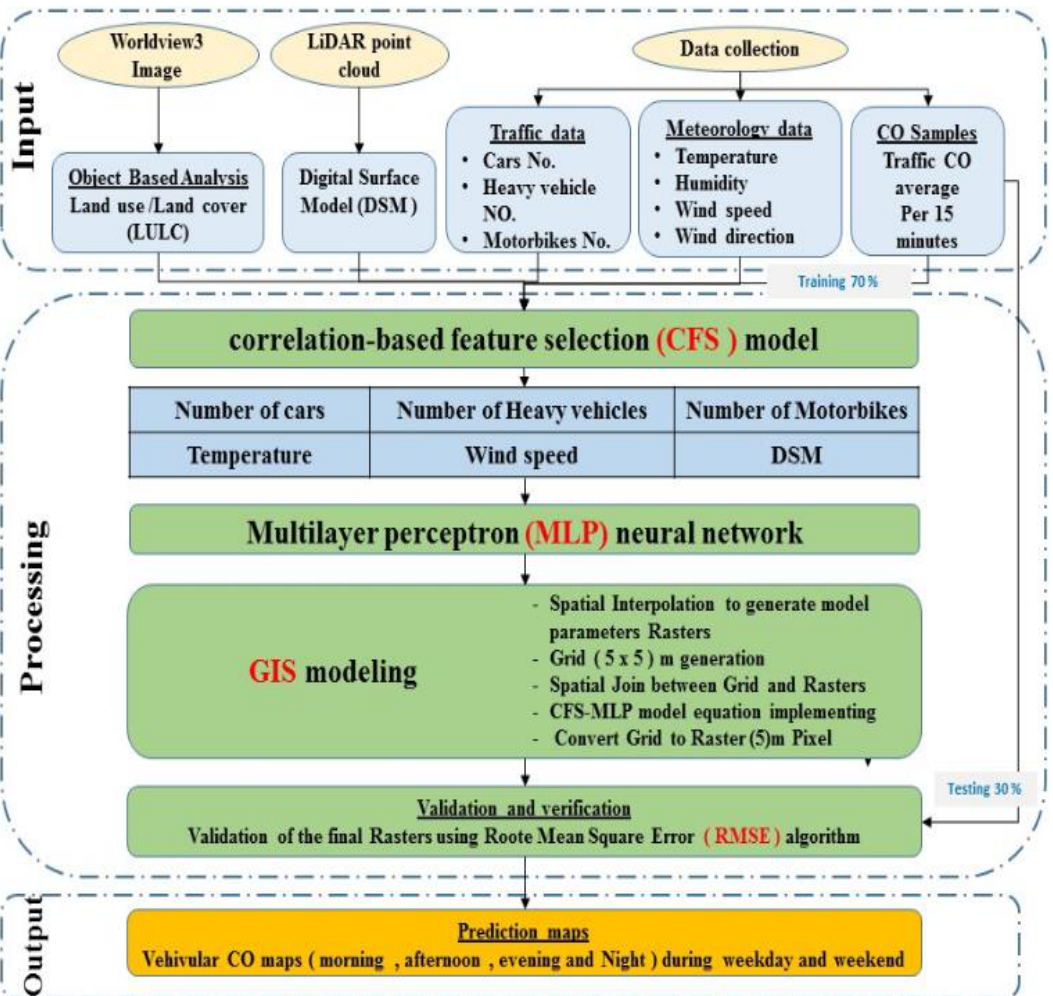
Figure 2. The overall methodological flow chart employed in this study.